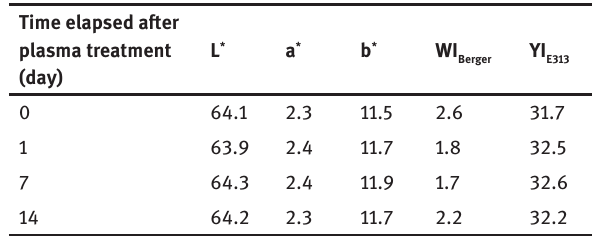
Table 6: Ageing of the color created by plasma treatment of the linen fabric. CIELab color coordinates, whiteness and yellowness indices as a function of time elapsed from the plasma treatment. a